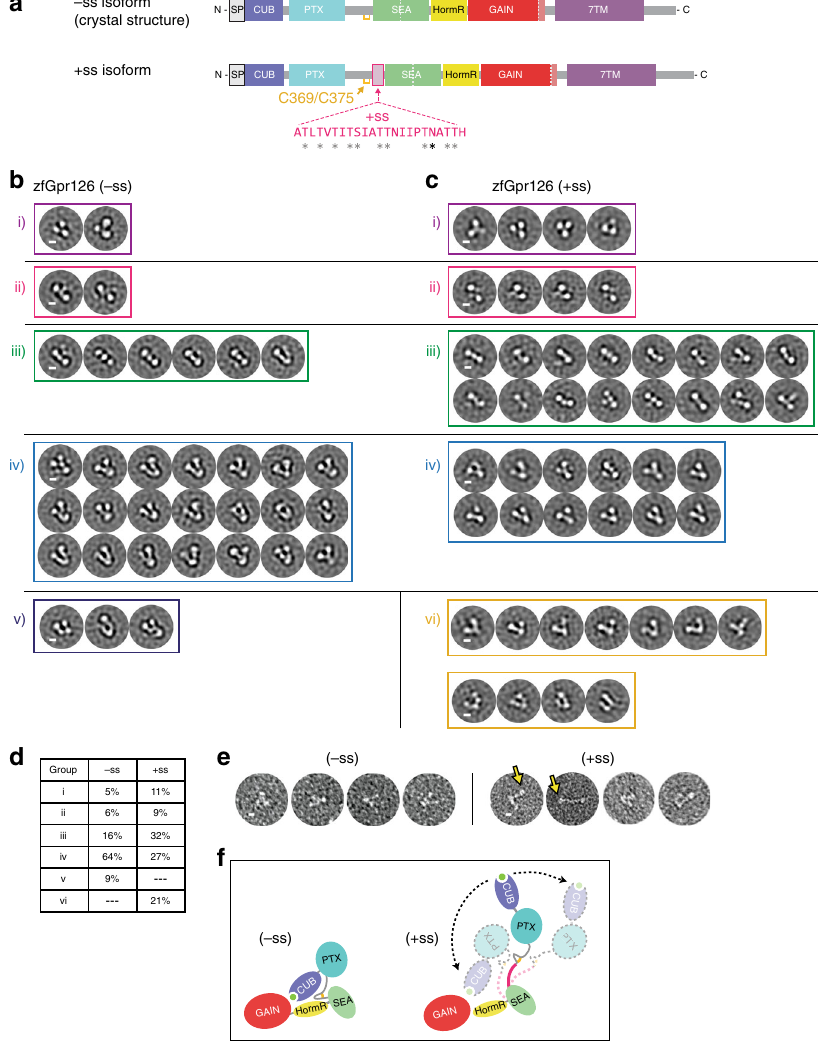
Fig. 3 Alternative splice isoforms of Gpr126 modulate ECR conformation. a Schematic diagram of Gpr126 splice isoforms generated by including ( + ss) or excluding ( − ss) exon 6. Residues encoded by exon 6 are colored magenta. Gray asterisks indicate potential O-linked glycosylation sites and the black asterisk indicates a predicted N-linked glycosylation site. The conserved disul fi de bond in the linker is colored yellow. b , c Negative-stain EM 2D class averages for − ss ( b ) and + ss ( c ) ECR constructs. Class averages are categorized according to similar orientations: (i, ii, iii, iv, v, and vi). (i, ii, iii, iv) are observed in both – ss and + ss isoforms. (vi) represents open-like conformations (>50° angle) that are observed only in the + ss isoform. (v) represents unidenti fi able miscellaneous views. Scale bars (white) represent 50 Å. d Quanti fi cation of percentage of particles per category for both isoforms. e Representative individual particles for both isoforms. Yellow arrows point to particles which are not in a closed conformation. f ECR conformations based on negative-stain EM are depicted as cartoons. The splice site is shown in magenta. Black arrows with dashed lines indicate dynamic ECR